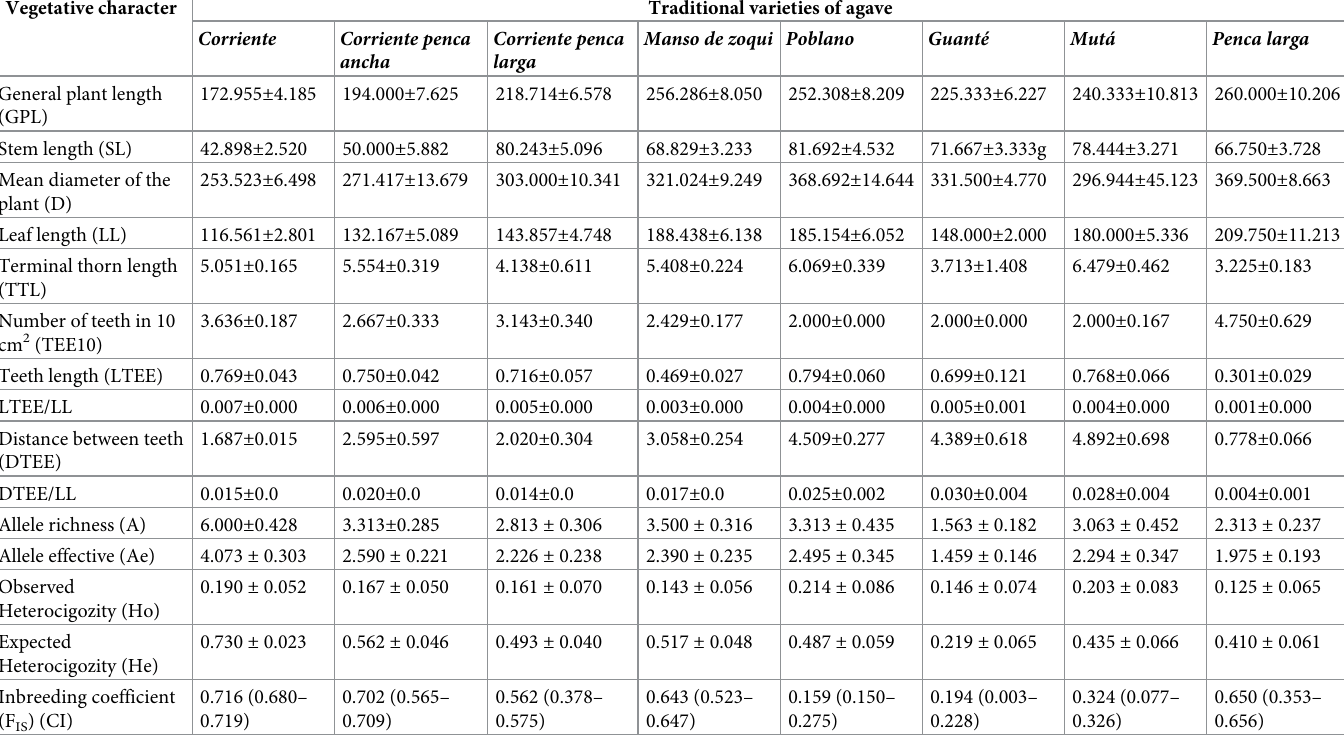
Table 4. Vegetative morphological characteristics of eight traditional varieties of pulque agave, identified by producers in the localities of La Coyotera and El Cubo , in the state of